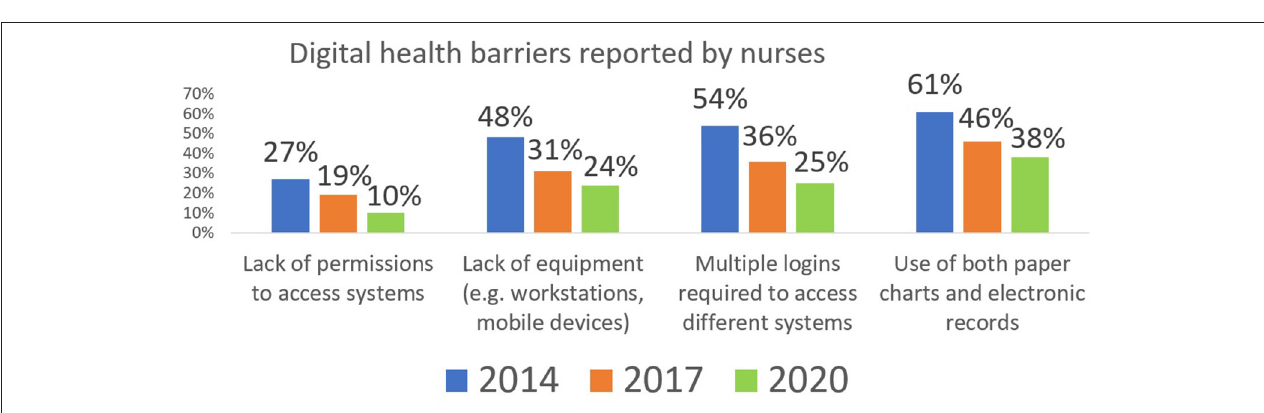
FIGURE 3 | Portion of Canadian Nurses Reporting Digital Health barriers. Sourced from the national surveys of Canadian Nurses, with responses from over 1,500 nurses in each of 2014, 2017 and 2020 ( 10).